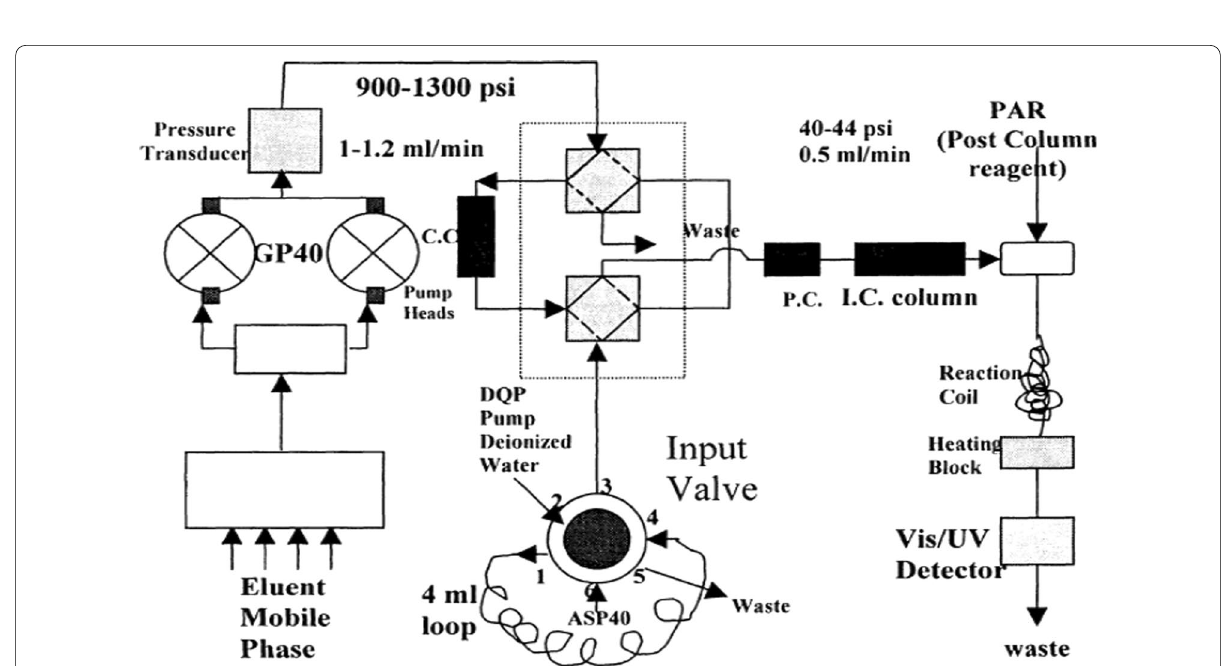
Fig. 10 Schematic diagram of Dionex DX-500 system (Kulisa et al.